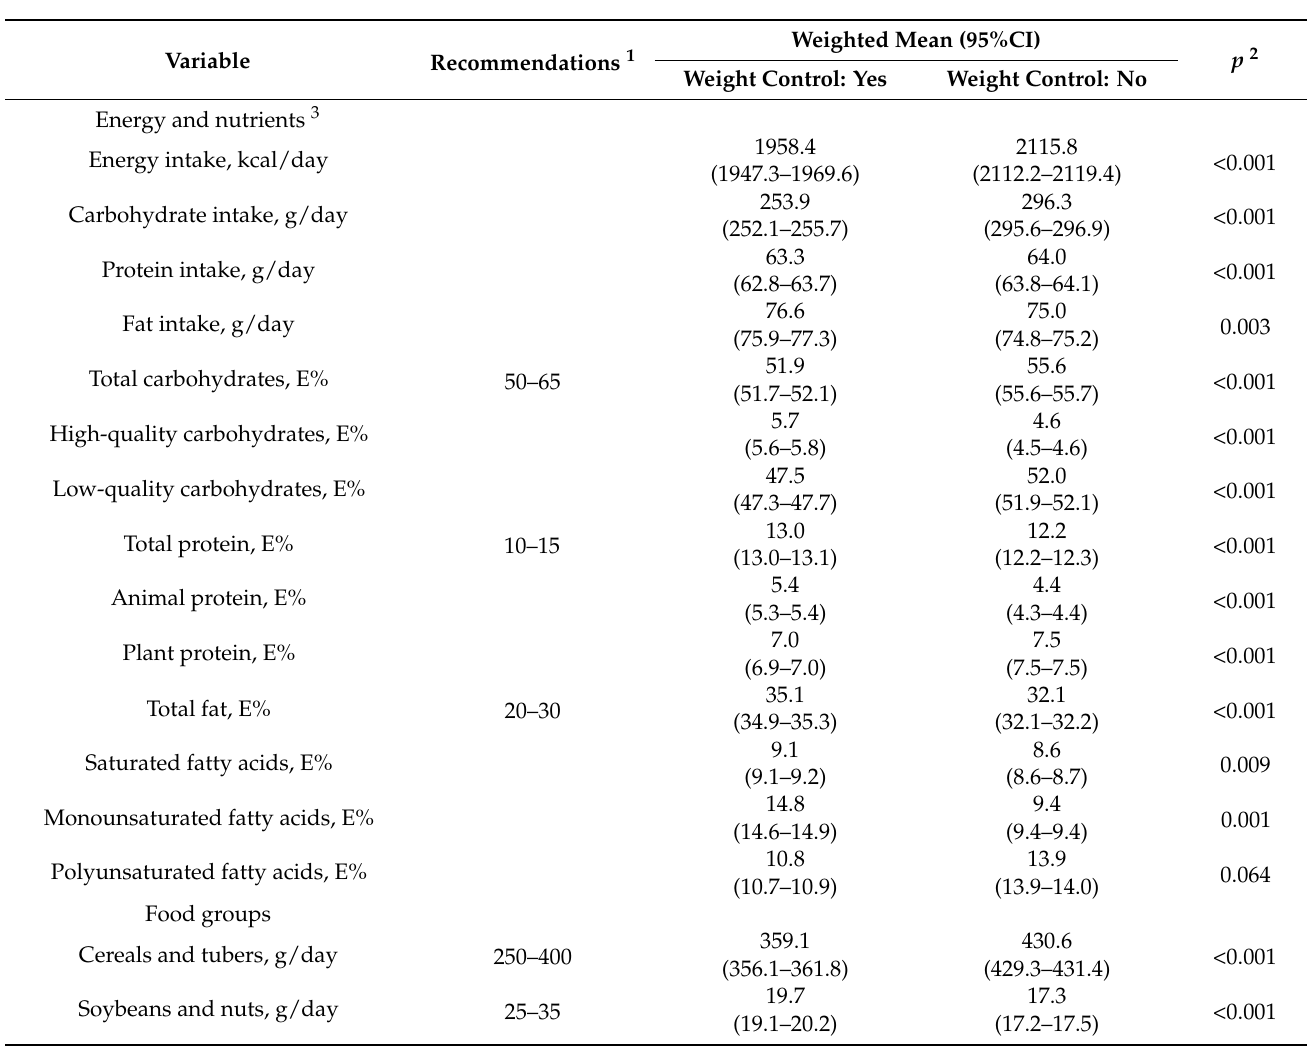
Table 2. Mean intake of dietary-related items among Chinese adults in the three rounds of China National Nutrition